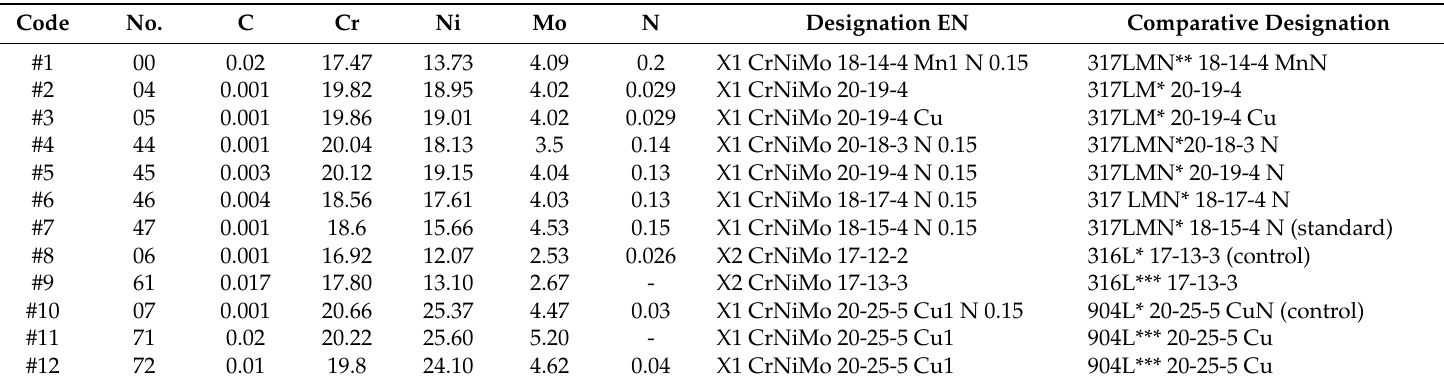
Table 1. Compositions in % weight of the alloys